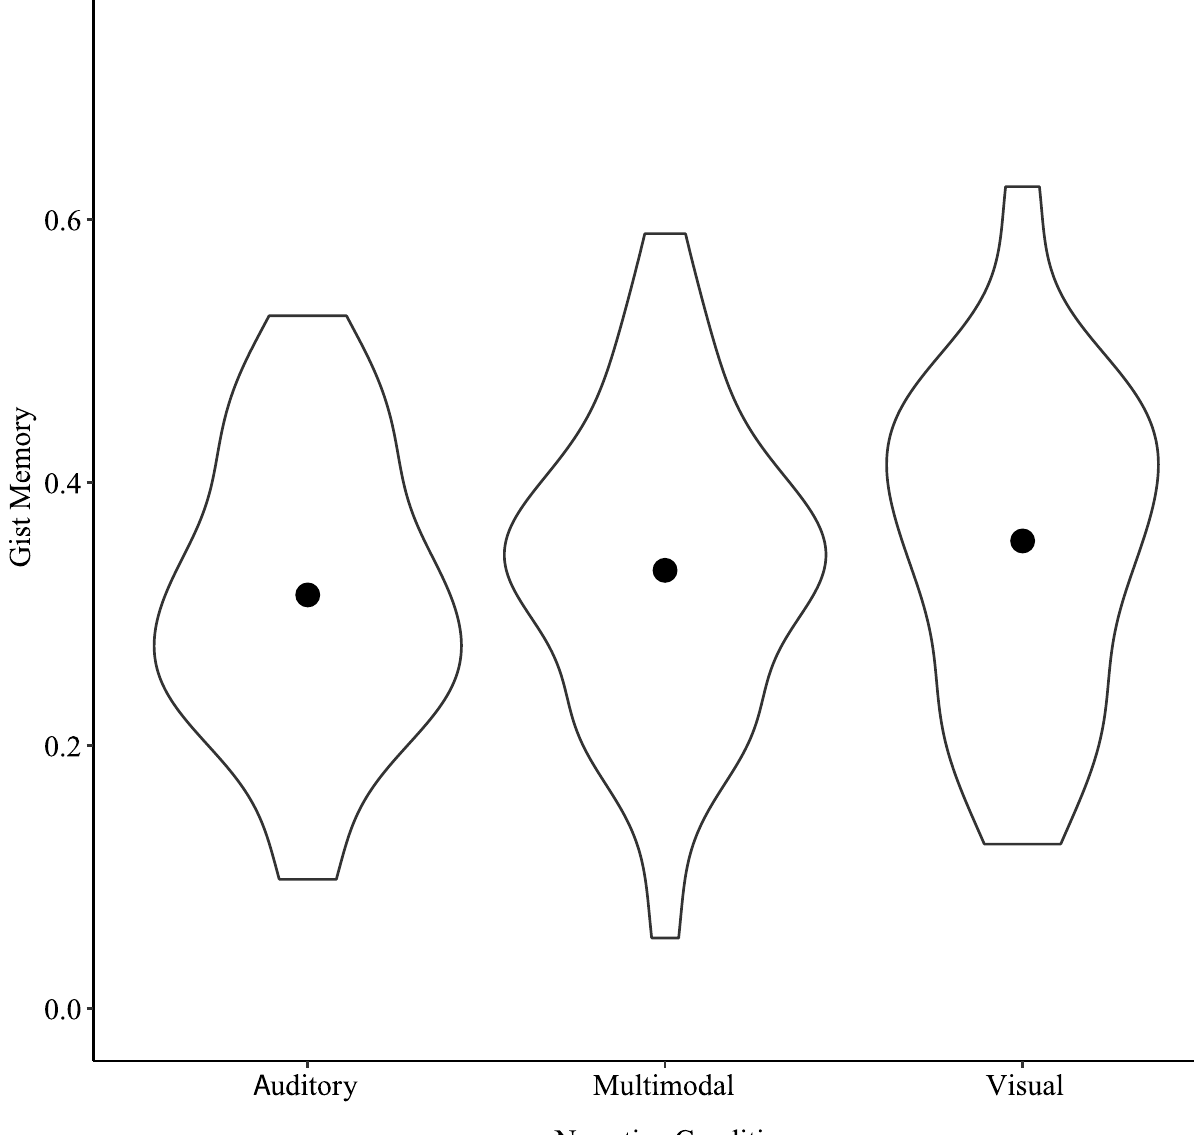
Fig 2. Gist memory by Narrative Condition for Study 1. Points show means for each Narrative Condition.